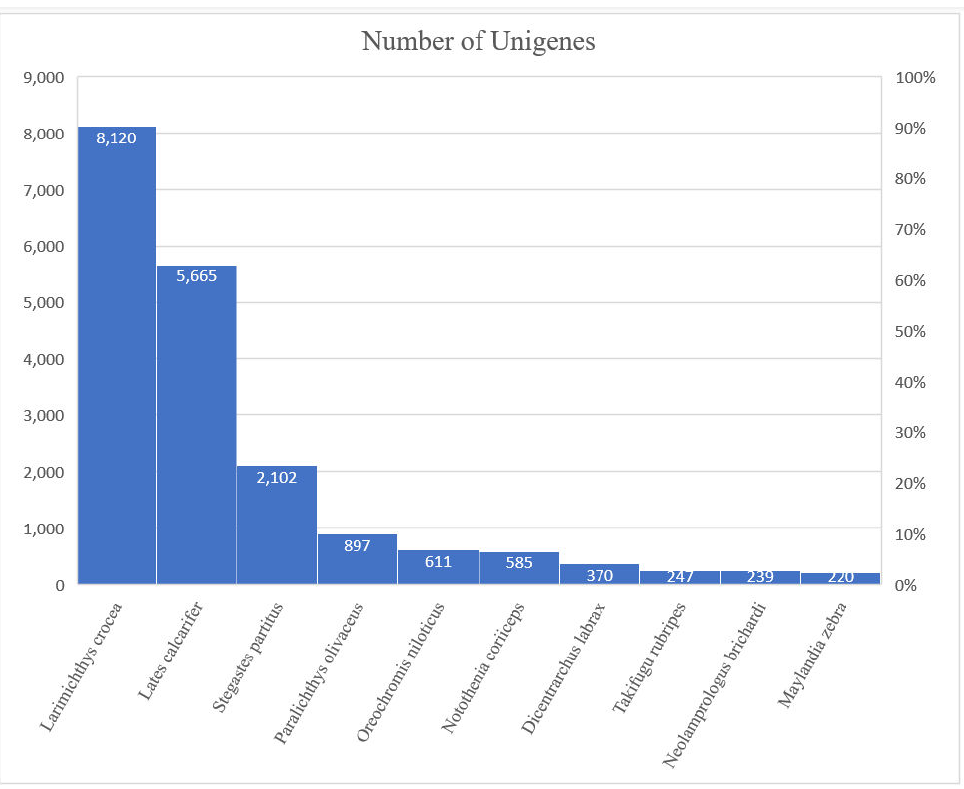
Figure 5. Species distribution results of a similarity search of Unigenes against the Nr